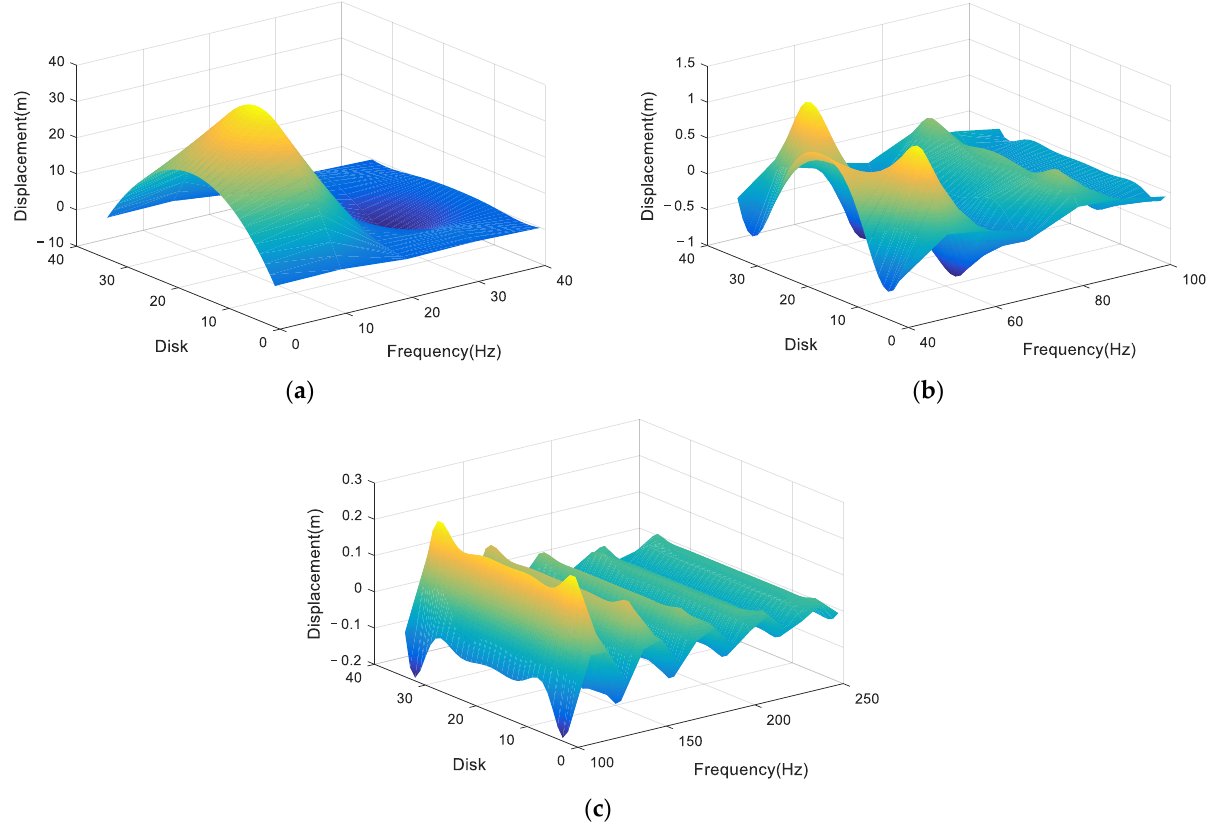
Figure 5. Displacement of each disk at 0 – 250 Hz. ( a ) Displacement of each disk at 0 – 40 Hz; ( b ) 40 – 100 Hz; and ( c ) 100 – 250 Hz.